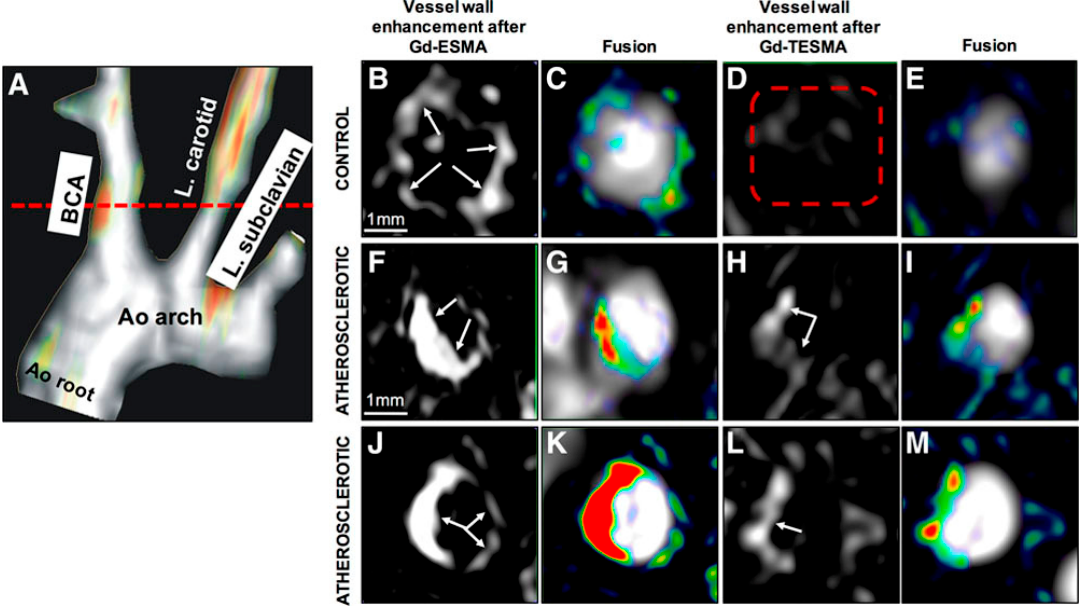
Figure 8. In vivo magnetic resonance imaging (MRI) comparison of vessel wall enhancement using